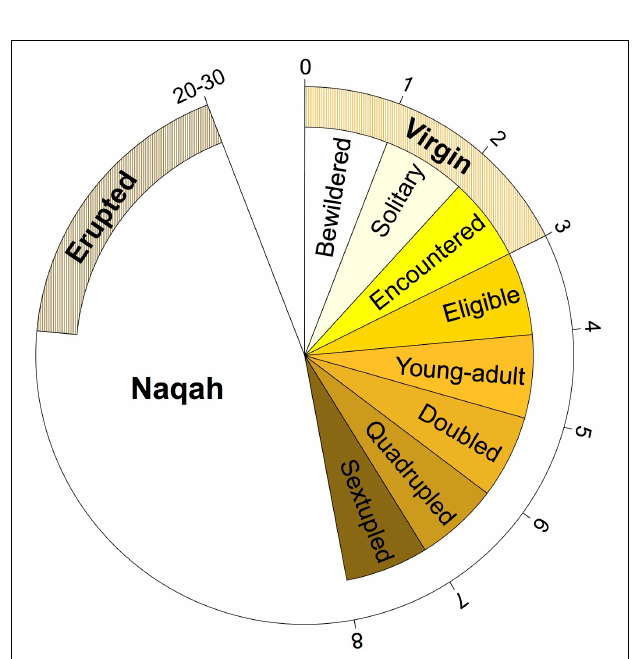
FIGURE 2 | Terminology of Mezayen camel age classes and their approximate age in years. Each age class represents a phase in the growth of a female camel (male terminology is similar) and does not depend on specific number of months/years. Outer numbers are approximate number of years for the completion of each age stage. For details regarding the terms and their meaning refer to Supplementary Table 1